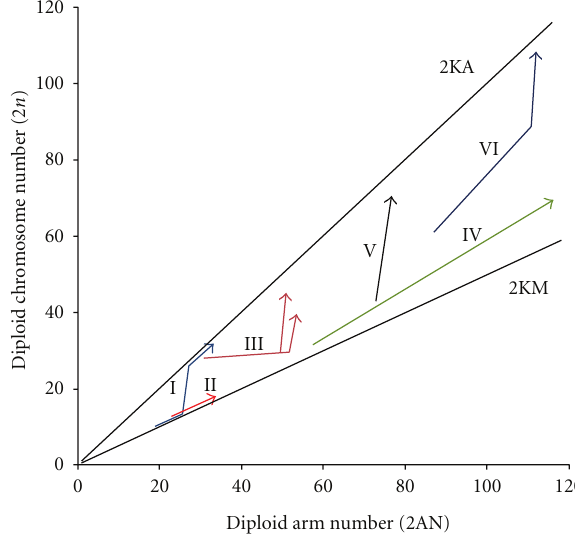
Figure 6: Possible pathways of karyotype evolution in several groups of Neotropical Pachycondyla sensu Brown. The Roman numbers correspond to the more representative species groups studied here (nomenclature according the last column of Table 1): I: Neoponera - crenata ; II: Pseudoponera ; III: Neoponera - foetida ; IV: Neoponera - apicalis ; V: Neoponera - verenae ; VI: Pachycondyla sensu stricto . This schematic representation follows the suggested model of Imai and Crozier [27] for karyotypical evolution in mammals and is based on a hypothesis of a karyotype variation essentially driven by